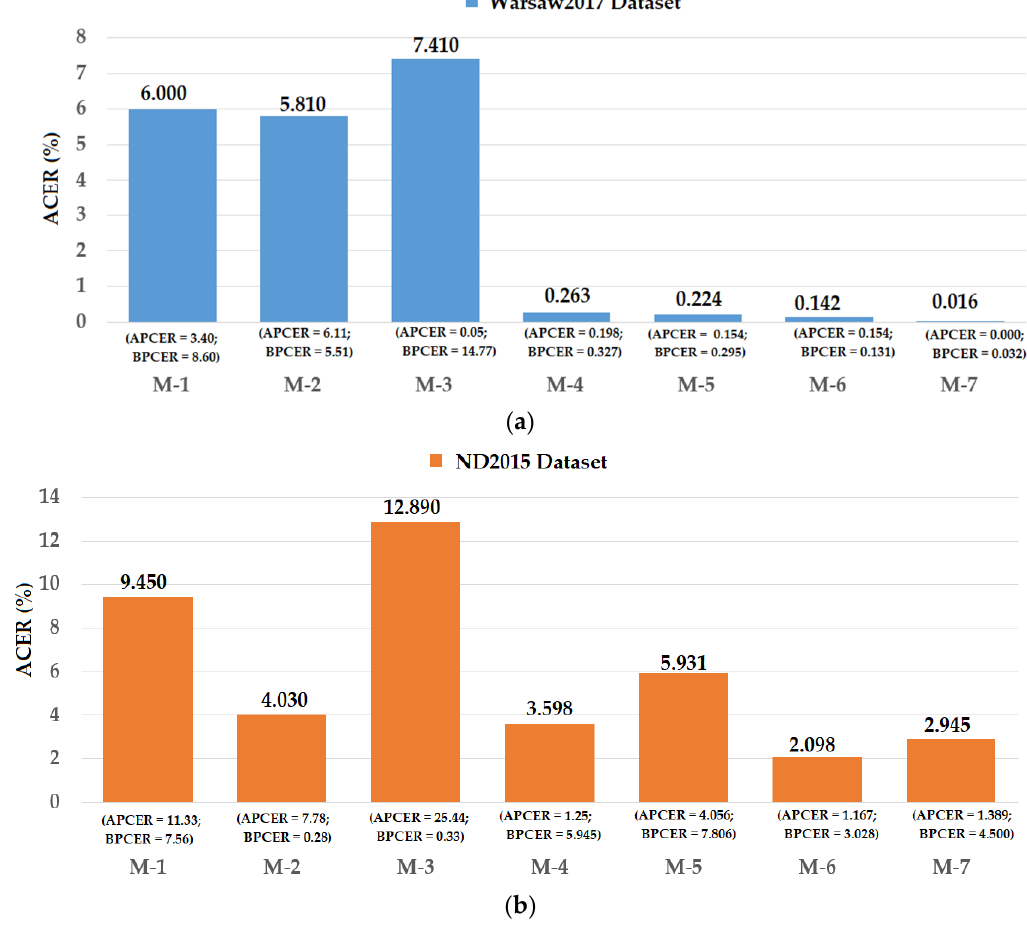
Figure 20. Comparison of detection error (ACER) between proposed method and previous methods using ( a ) Warsaw2017 and ( b ) ND2015 datasets. Note: (M-1) CASIA method [48]; (M-2) Anon1 method [48]; (M-3) UNINA method [48]; (M-4) CNN-based method [32]; (M-5) MLBP-based method [29]; (M-6) Proposed method based on feature level fusion; and (M-7) Proposed method based on score level fusion.